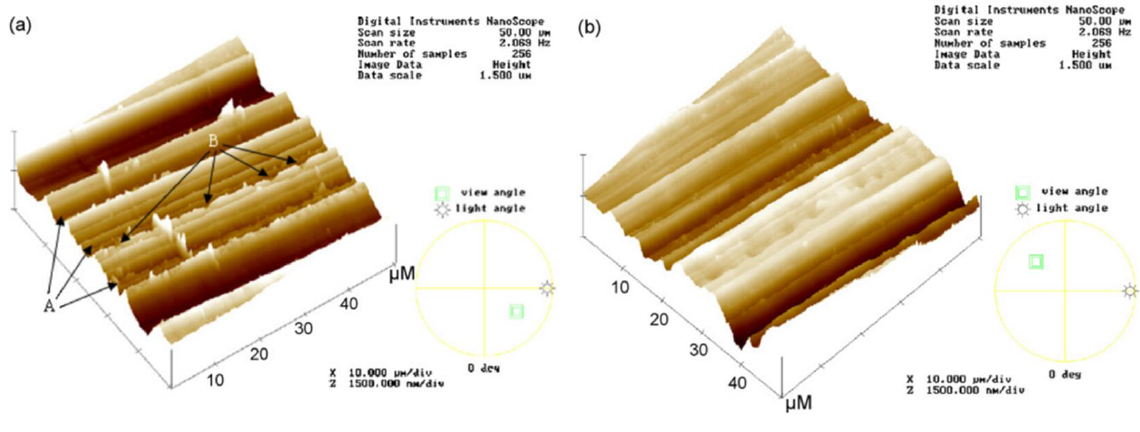
Figure 2: AFM pictures of nano-ZrO 2 surface: (a) machining through common grinding method; (b) ultrasonic assistant grinding method [57]